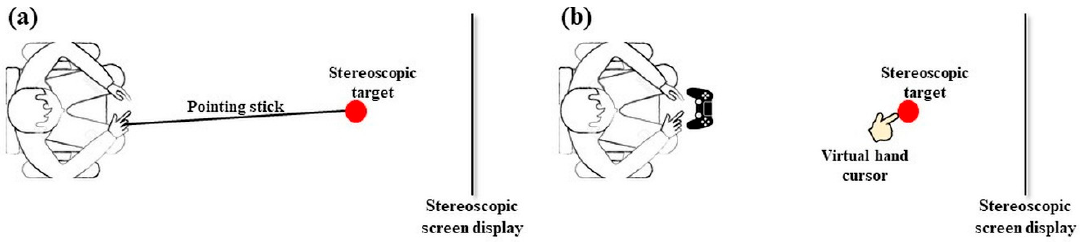
Figure 1. Illustration of the interaction techniques. ( a ) Direct pointing technique: directly pointing at the stereoscopic target with a stick, and ( b ) indirect cursor technique: controlling the gamepad to place the virtual hand cursor on the stereoscopic target.